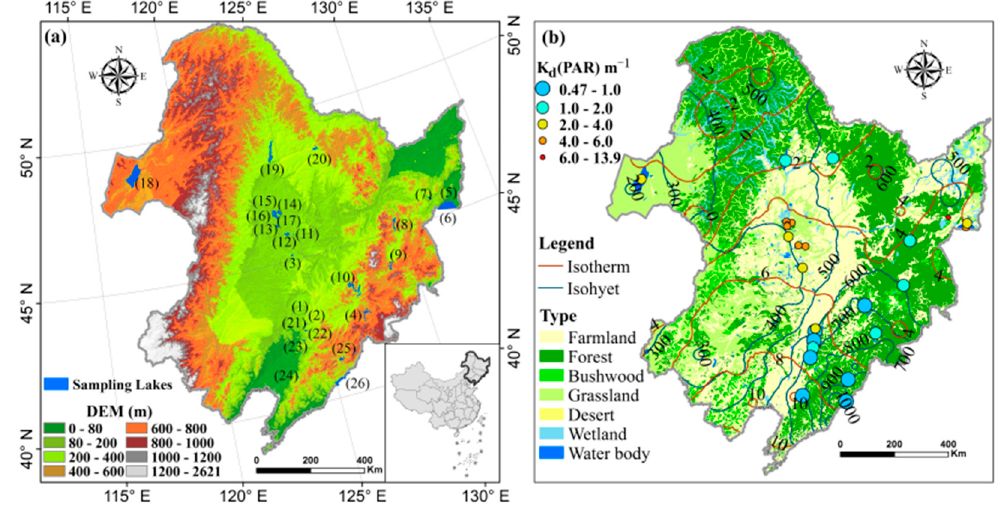
Figure 1. Study area map: ( a ) Digital elevation model (DEM) and sampling lakes with corresponding lake ID; and ( b ) type of vegetation and spatial distribution of the K d (PAR) derived from in situ measurements, combined with isotherm and isohyets in Northeast China.